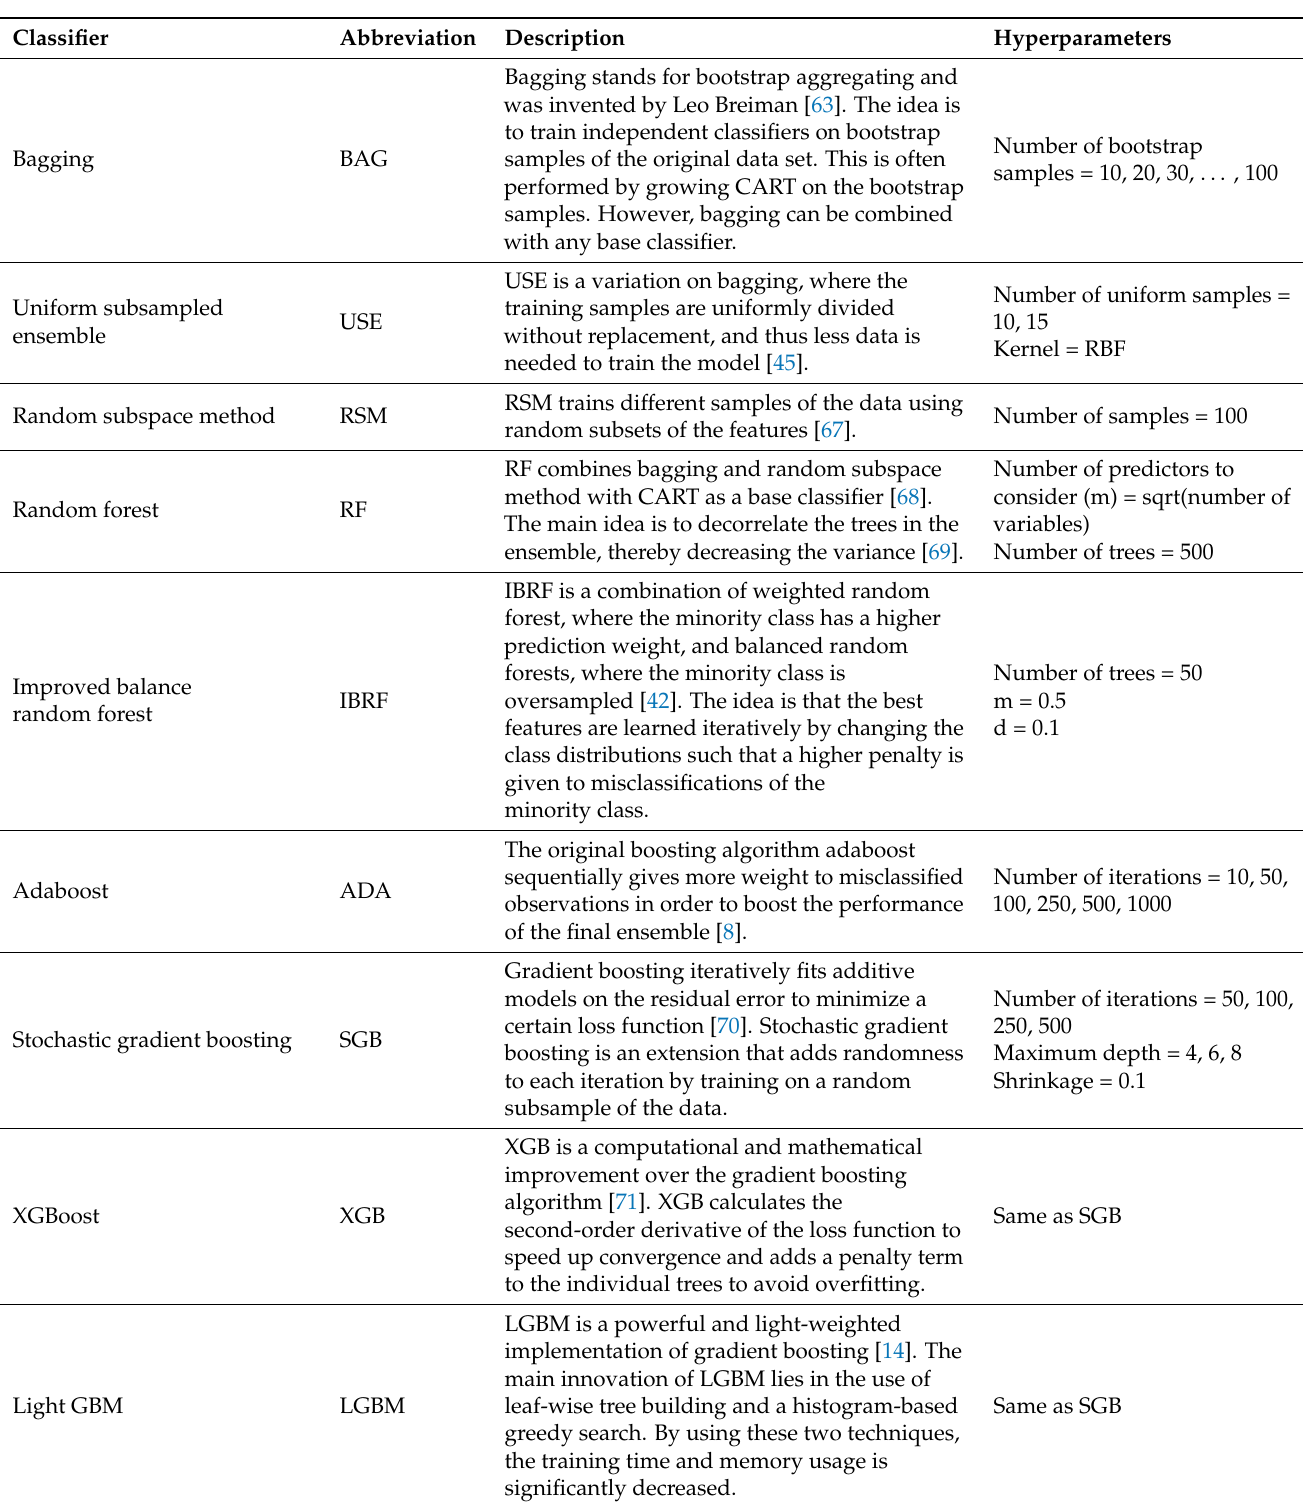
Table 3. Overview of the homogeneous